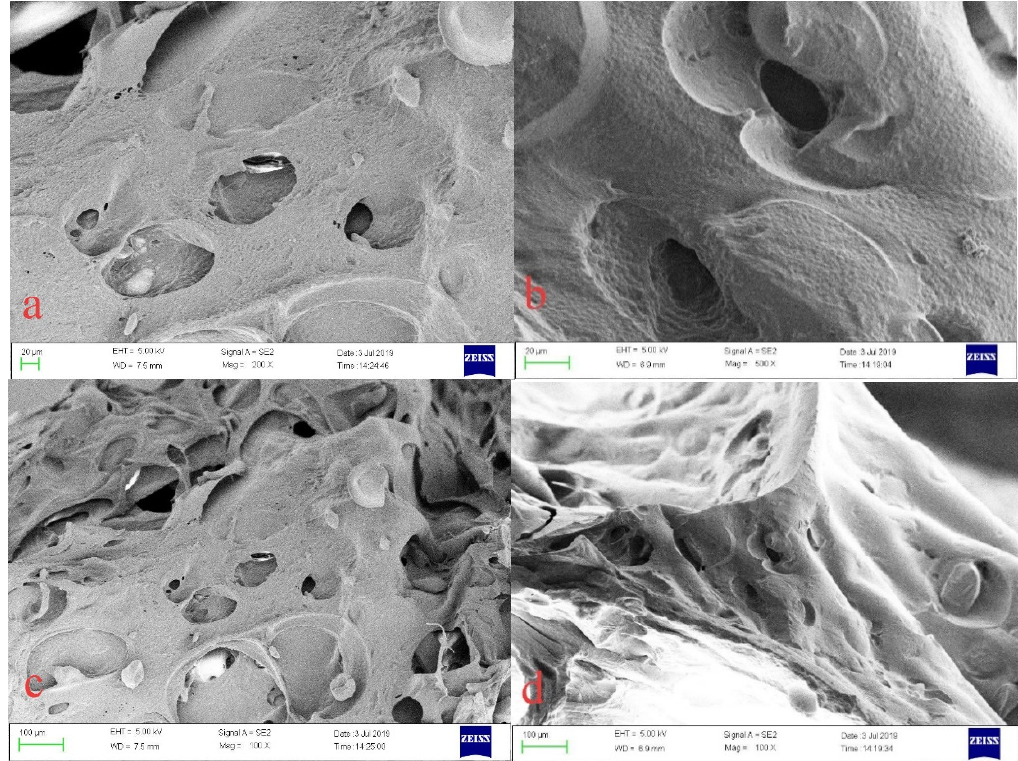
Figure 8. Scanning electron microscopy (SEM) micrographs of the CMC/P (NIPAM-co-AA) hydrogel before and after adsorption of U(VI): ( a ) before adsorption, 20 μ m; ( b ) after adsorption, 20 μ m; ( c ) before adsorption, 100 μ m; and ( d ) after adsorption, 100 μ m.